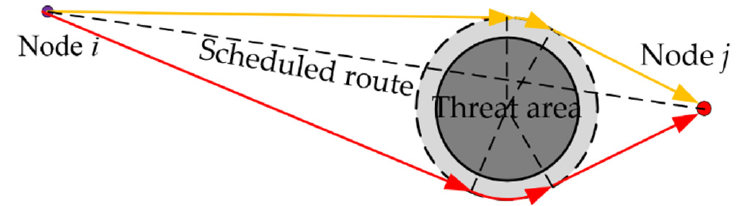
Figure 3. Evasion policy for a single threat area.